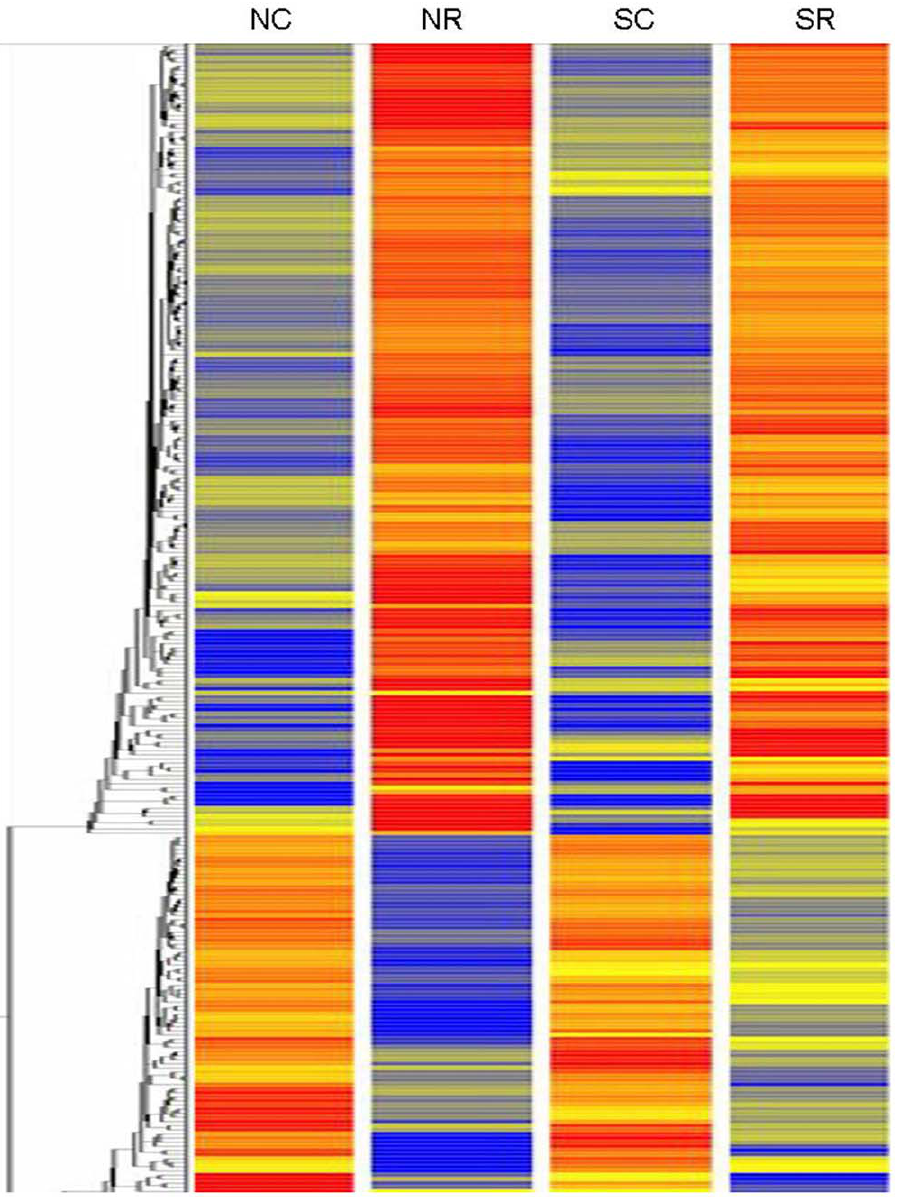
Figure 2. Heat map and dendrogram of differentially expressed transcripts. GeneSpring analysis of normal and SSc human dermal fibroblasts exposed to rottlerin. RNA was isolated from replicate samples of normal human dermal fibroblasts incubated under control conditions (NC) or cultured with 5 m M rottlerin (NR), or from SSc derived human dermal fibroblasts under control conditions (SC) or cultured with 5 m M rottlerin (SR), labeled and applied to Affymetrix human U133 2.0 Plus microarrays. Dendrograms are reflective of the genes with a differential expression of . 2 fold in the two experimental conditions. In the dendrogram shown, a shorter arm indicates higher similarity, whereas a longer arm indicates lower similarity. Genes with significant expression (p , 0.05) between untreated and rottlerin treated fibroblasts were hierarchically clustered by similarity in expression profile. The resulting heat map of the dendrogram tree reveals groups of genes with high (red) expression levels, low expression levels (blue) or background expression levels (yellow).